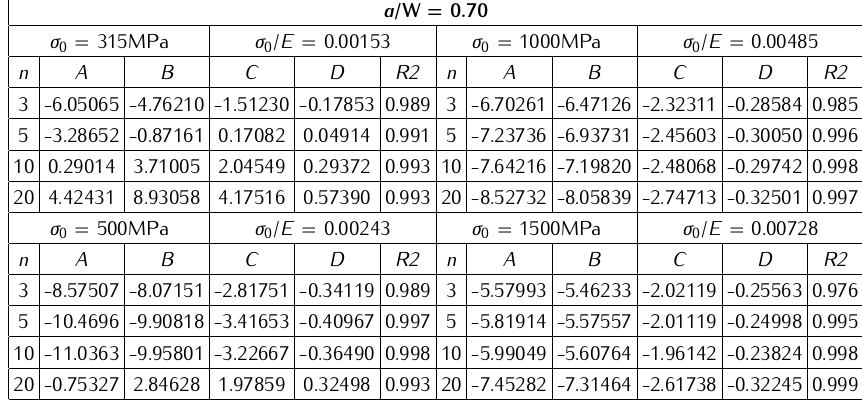
Table 11. The coefficients of equation (13) for SEN(T) specimen with the crack length a / W =0.70. a /W = 0.70 σ 0 = 315MPa σ 0 / E = 0.00153 σ 0 = 1000MPa σ 0 / E = 0.00485